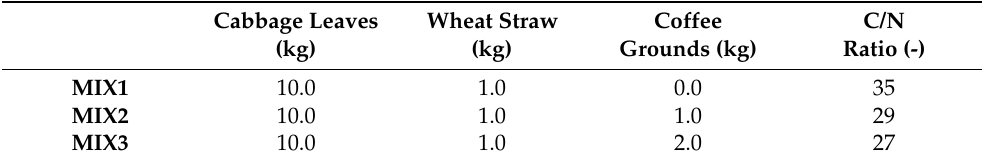
Table 2. Composition of composted biological